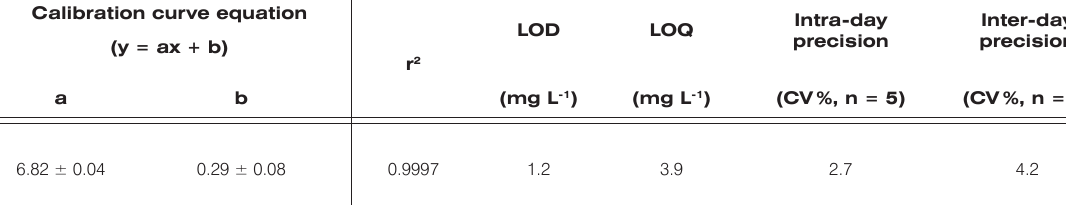
Table 1. Features of the proposed methodology Calibration curve equation